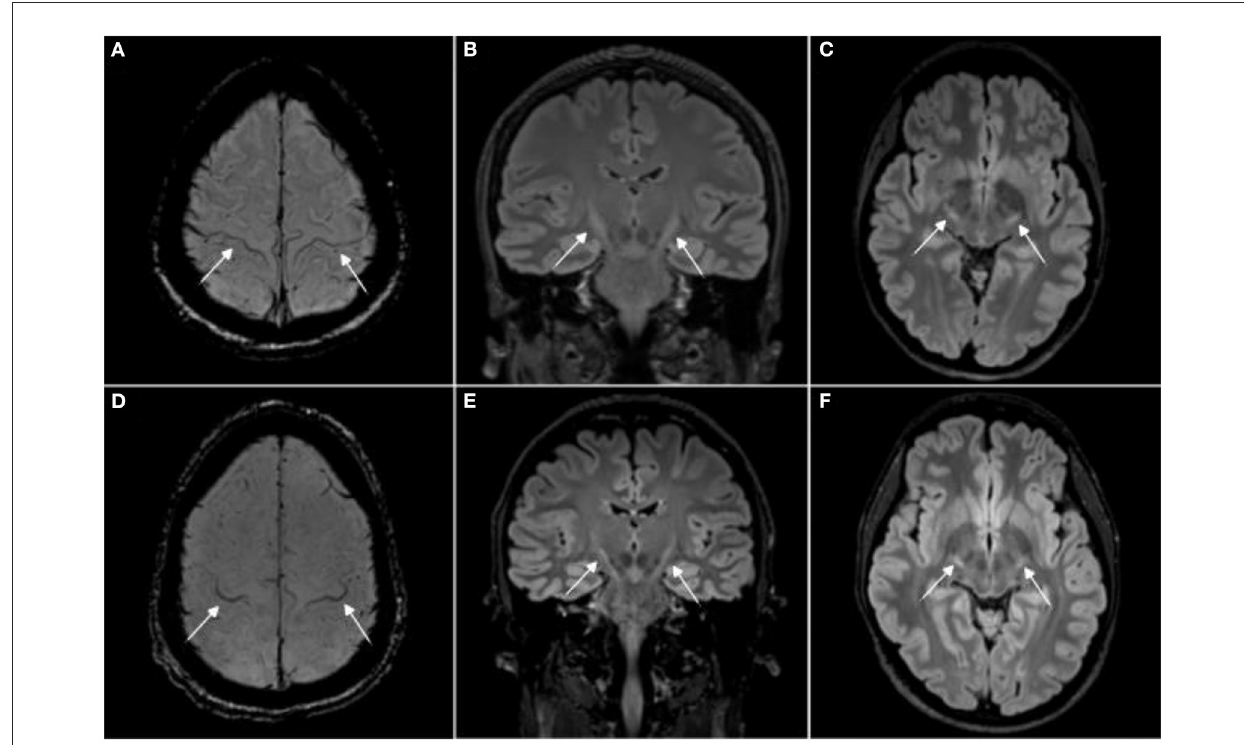
FIGURE1 Magnetic resonance imaging signs in human amyotrophic lateral sclerosis (ALS). Magnetic resonance imaging (MRI) from two amyotrophic lateral sclerosis (ALS) patients with the “motor band sign,” i.e., motor cortex hypointensities, on susceptibility weighted imaging [SWI, (A, D) ] and T2 hyperintensities along the corticospinal tract on 3T 3D T2w-FLAIR (B, C, E, F) . Image adjusted from (20). For comparison, T2 signal changes in rodent brain stem motor nuclei are shown in